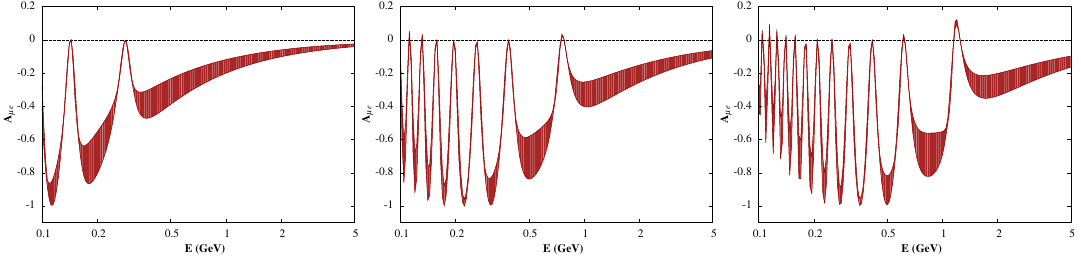
Figure 4 . Plots of the CP asymmetry parameter ( A (cid:22)e ) with energy E for (cid:12)xed baseline lengths corresponding to di(cid:11)erent experiments in case of IO. Figure (a) is for T2K with L = 295Km; (cid:12)gure (b) is for NO (cid:23) A with L = 810Km and (cid:12)gure (c) is for DUNE with L = 1300Km. The plot is for (cid:14) = 3 (cid:25)= 2, while the bands and the horizontal dashed lines have the same speci(cid:12)cations as in (cid:12)gure